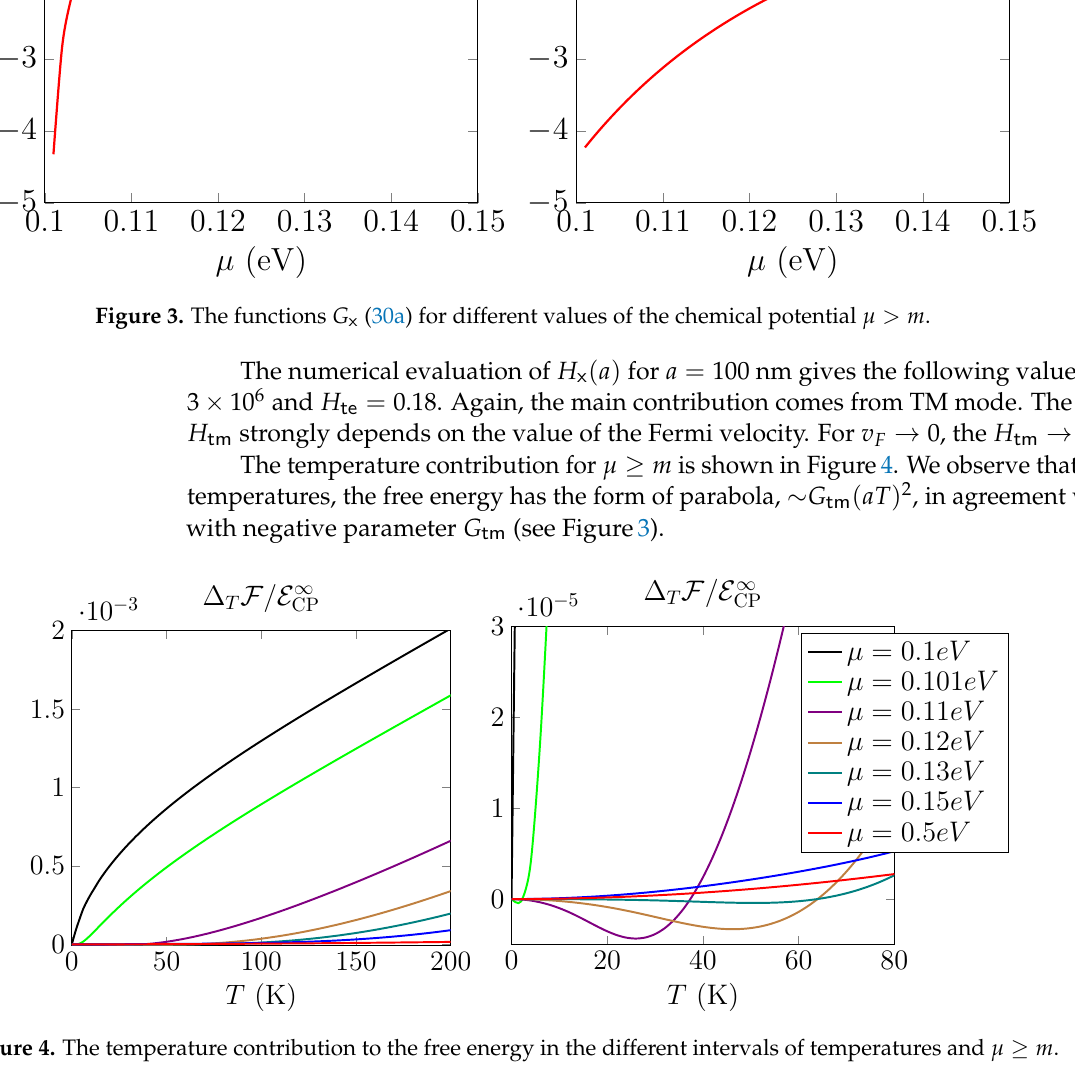
m . Figure 4. The temperature contribution to the free energy in the different intervals of temperatures and µ ≥ The closer µ > m to m , the smaller domain of temperature T where this approximation is valid, and the greater value of the parameter of parabola G tm , in agreement with Figure 3. If µ = m , this domain becomes zero, and the free energy drastically changes its form. If µ 0, the part of the curve which is out of this domain (the vertical part of the green curve, → for example) goes to free energy for this very special position with µ = m (black curve). = 0, the derivative of free energy m Therefore, for any infinitely small difference µ − (cid:54)